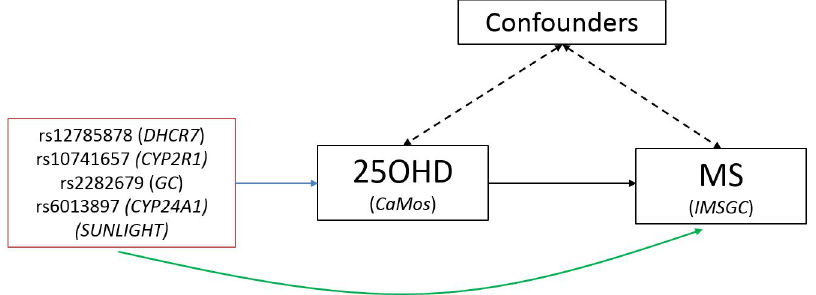
Fig 1. Schematic representation of Mendelian randomization analysis. The leftmost box lists SNPs that were genome-wide significant for 25OHD level in SUNLIGHT ( n = 33,996). The blue arrow represents the effect of SNPs on multiply adjusted natural-log-transformed 25OHD level using data from CaMos ( n = 2,347). The green arrow represents the causal association of decreased 25OHD level with the risk of MS using data from the largest genetic association study to date for MS (the IMSGC Immunochip study, up to 14,498 cases and 24,091 healthy controls).